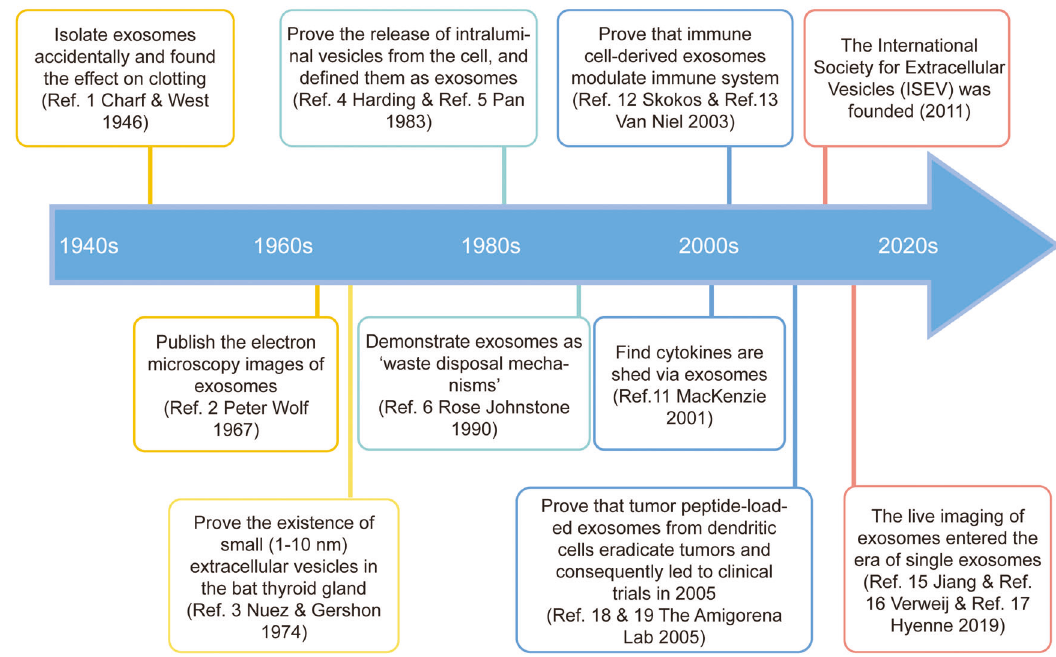
Fig. 1 Timeline of exosomes milestones. In 1946, the fi nding of one clotting factor, similar to the thromboplastic protein, by Chargaff was considered as the beginning of the fi eld of extracellular vesicles (EVs). The EV fi eld emerged the exponential growth in the early 21st century. In 2011, the foundation of the International Society for Extracellular Vesicles (ISEV) promoted the development of exosomes extremely. In 2019, the imaging of exosomes entered the era of single exosomes in